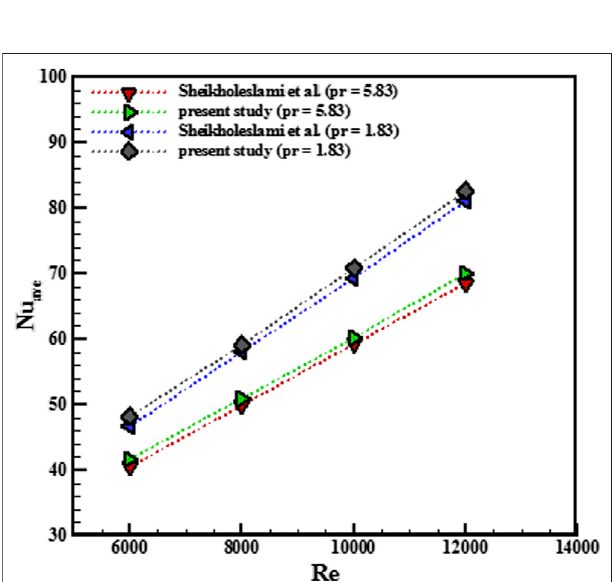
FIGURE 2 | The outcomes of various node numbers.